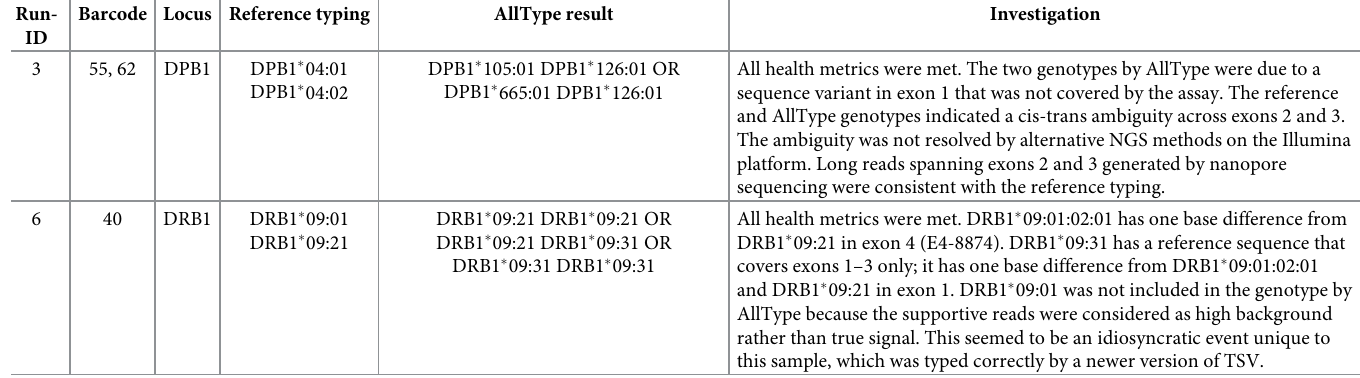
Table 3. Discordant results and further investigation.